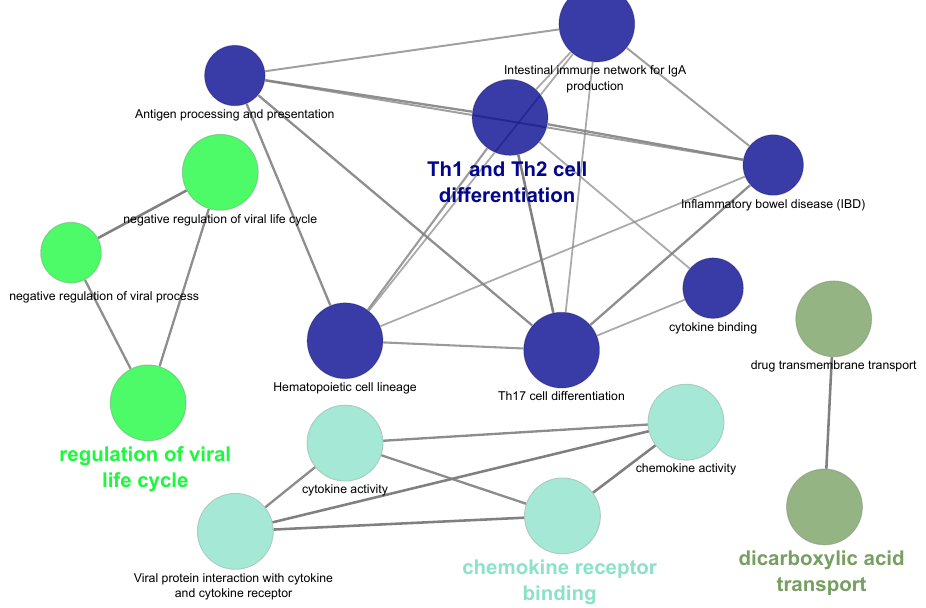
Figure 3. Gene Ontology (GO) terms and Kyoto Encyclopedia of Genes and Genomes (KEGG) pathways associated with significantly di ff erentially expressed genes between Finnsheep and Texel. The functional grouping option in ClueGO categorized 16 GO terms and pathways into four groups using kappa score where the genes shared between the terms are iteratively compared to form functional